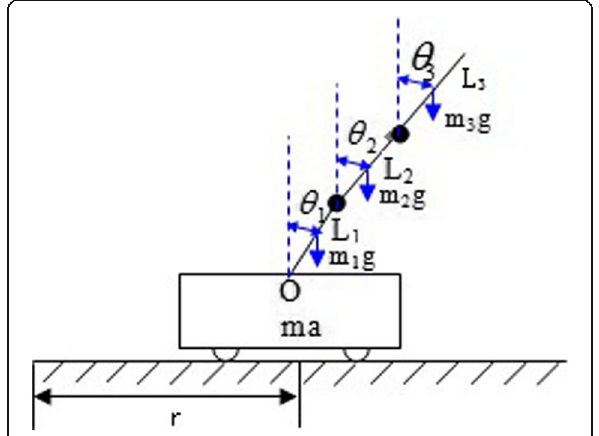
Fig. 1 Schematic diagram of the three level inverted